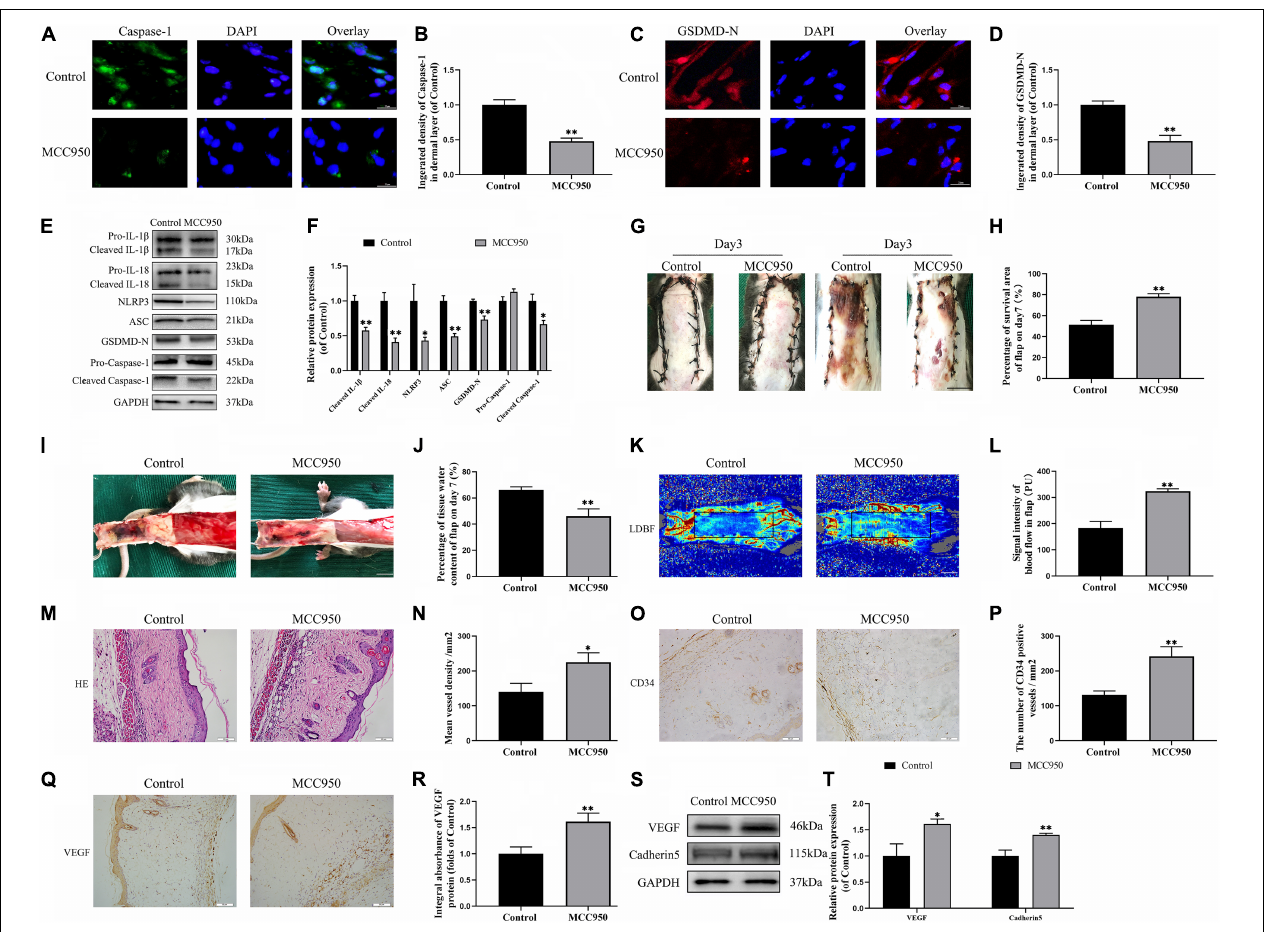
FIGURE 2 | NLRP3-mediated pyroptosis triggers the necrosis of flaps. (A) Immunofluorescence to evaluate the caspase-1 level was conducted to exhibit the pyroptosis level in the skin flaps (scale bar: 25 mm). (B) The fluorescence intensity of caspase-1 analyzed using ImageJ. (C) Image of the immunofluorescence staining of GSDMD-N in skin flaps (scale bar: 25 mm). (D) The fluorescence intensity for GSDMD-N. (E) Western blotting of pyroptosis related proteins in flap tissue from the control and MCC950 groups. (F) Quantification of pyroptosis related proteins immunoblots. (G) Digital images of flap necrosis from the control and MCC950 groups (scale bar, 1.0 cm). (H) Histogram showing the percentage of viable flap area. (I) Digital images of the inner side of the random flap in each group exhibiting tissue edema (scale bar, 1.0 cm). (J) Quantification of the flap tissue water content. (K) Full field LDBF images of flaps by LDBF (scale bar, 1.0 cm). (L) Quantification of signal intensity of blood flow. (M) Morphologic observation of flap tissue by H&E staining (original magnification, × 200; scale bar, 50 µ m). (N) H&E staining to show vessels. (O) The expression of CD34 to mark vessels was evaluated by immunohistochemistry staining (original magnification, × 200; scale bar, 50 µ m). (P) Histogram showing the CD34-positive vessel densities (Q) Immunohistochemistry for VEGF on the skin flaps from the control and the MCC950 groups (original magnification, × 200; scale bar, 50 µ m). (R) Histograms of optical density values for VEGF in IHC. (S) Western blotting of VEGF and cadherin-5 in flap tissue from the control and MCC950 groups. (T) Quantification of VEGF and cadherin-5 immunoblots. Values represent the mean ± SEM, n = 6 per group. * p < 0.05 and ** p < 0.01, vs. control